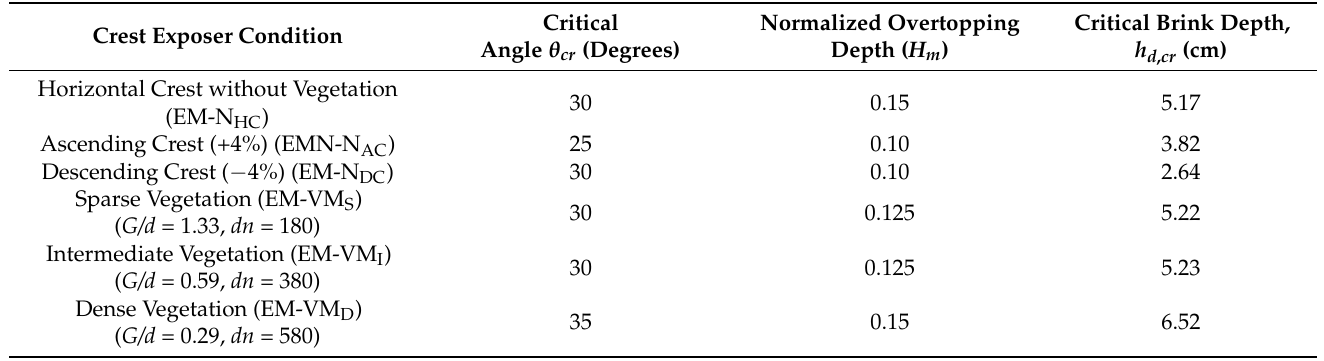
Table 4. Summary of the first free nappe observation of the experimental